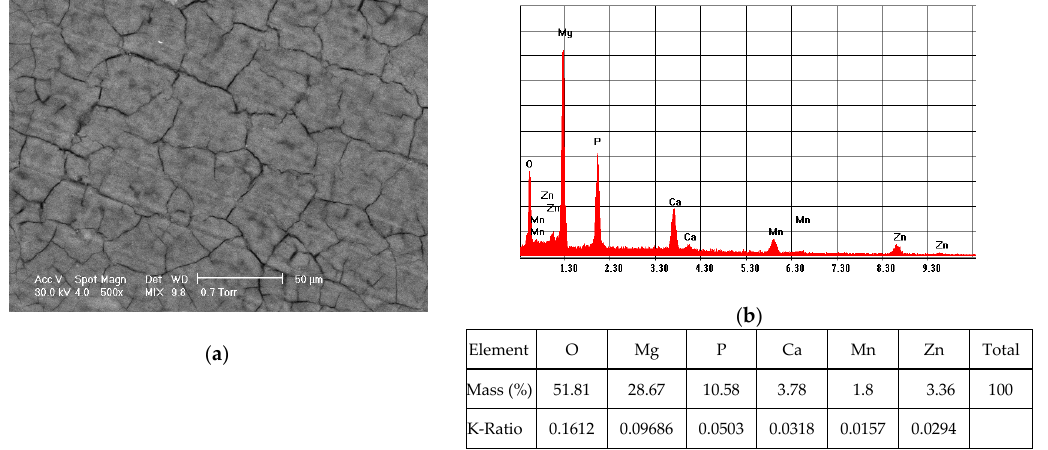
Figure 3. SEM images (magnification 500×) of the coated ZM21 sample ( a ) and corresponding EDS spectrum ( b ).